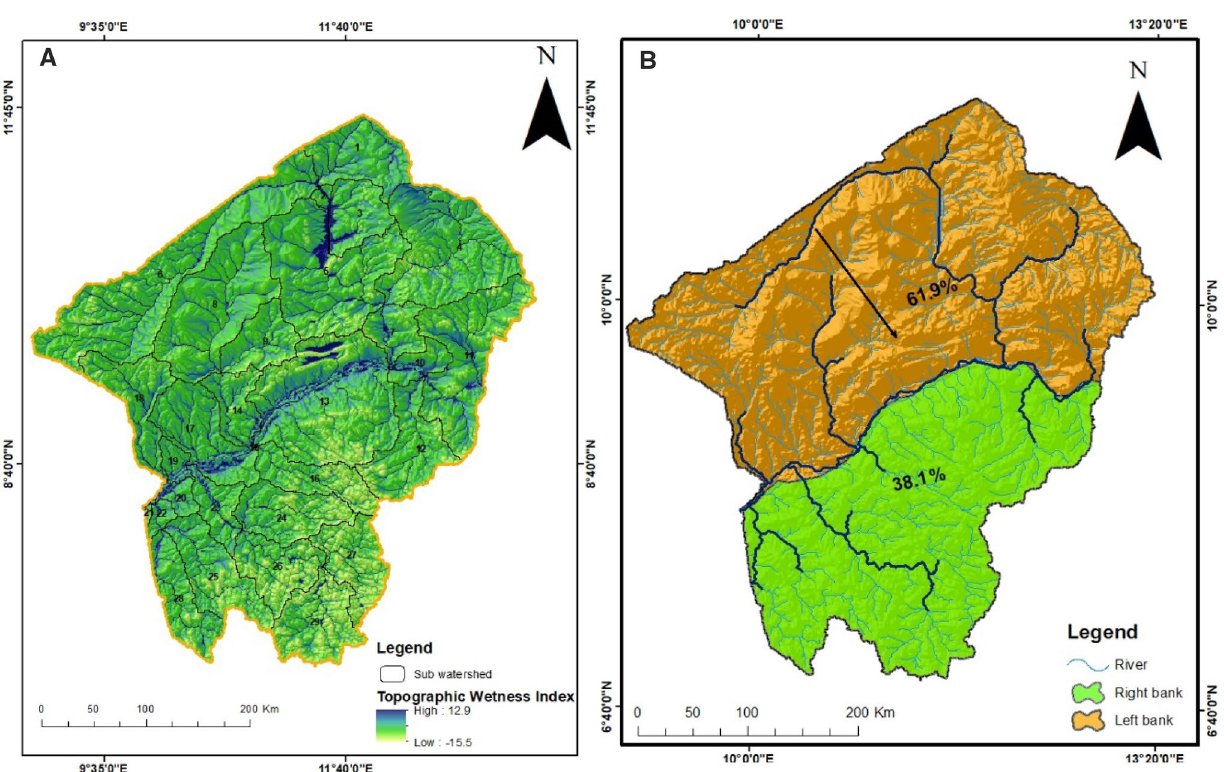
Fig. 11 a Topographic Wetness Index, b Asymmetrical